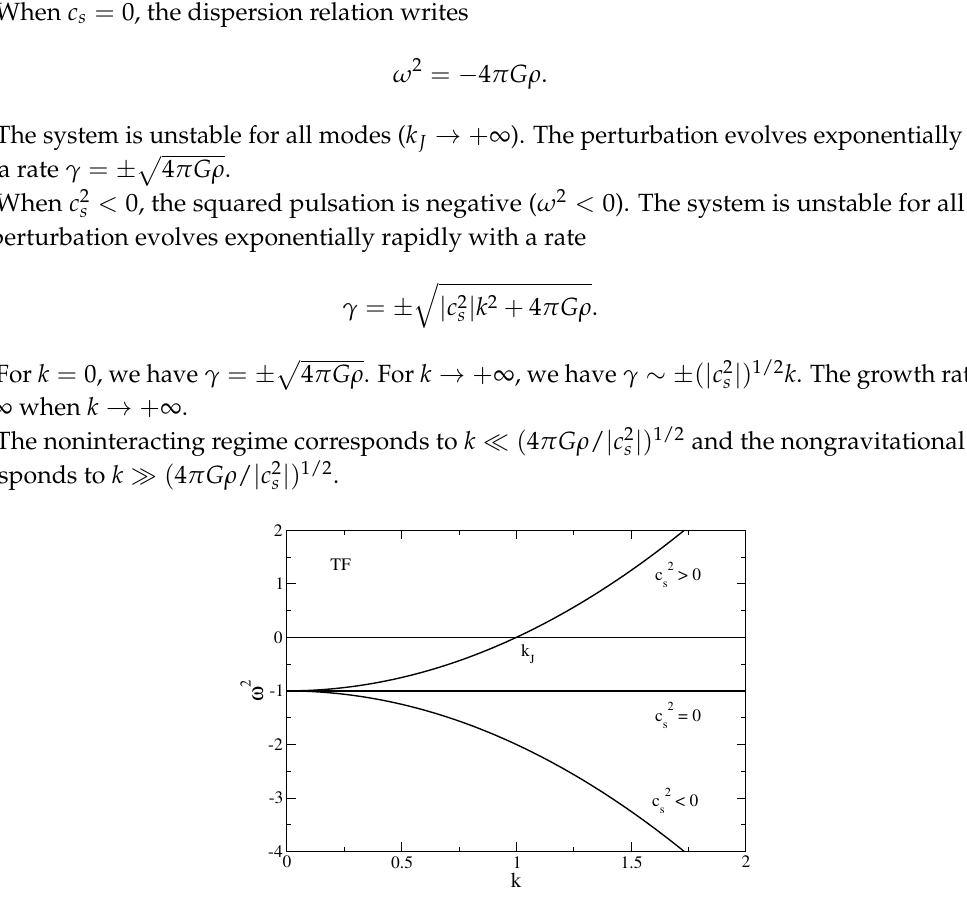
Figure 3. Dispersion relation for dissipationless self-gravitating BECs in the TF limit (¯ h = 0). We have normalized the wavenumber by ( 4 π G ρ / | c 2 s | ) 1/2 and the pulsation by ( 4 π G ρ ) 1/2 . This is equivalent to taking 4 π G = ρ = | c 2 s | = 1 in the dimensional